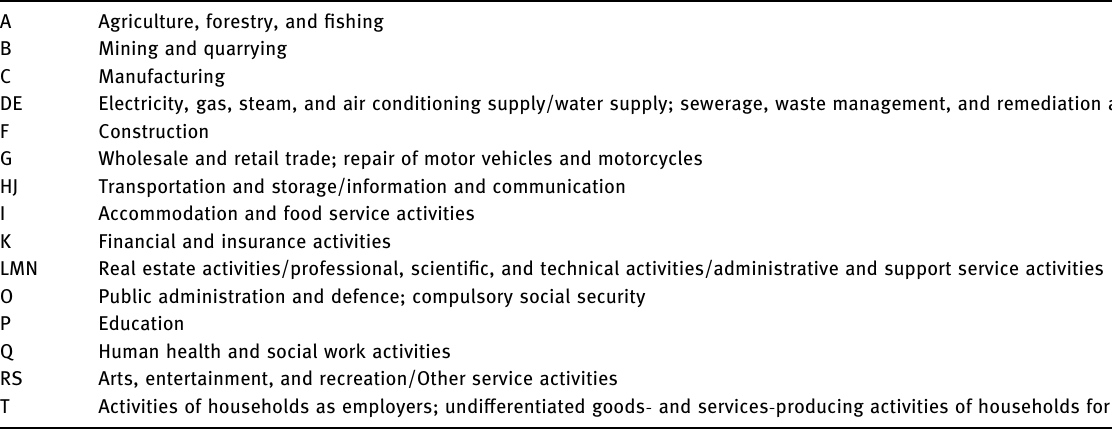
Table 1: Productive sectors from the